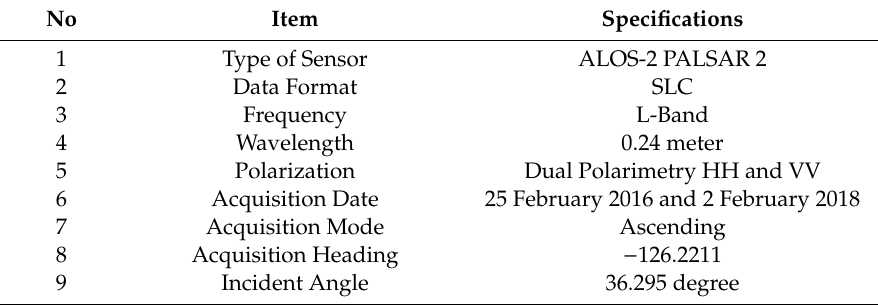
Table 1. Specifications of the data.